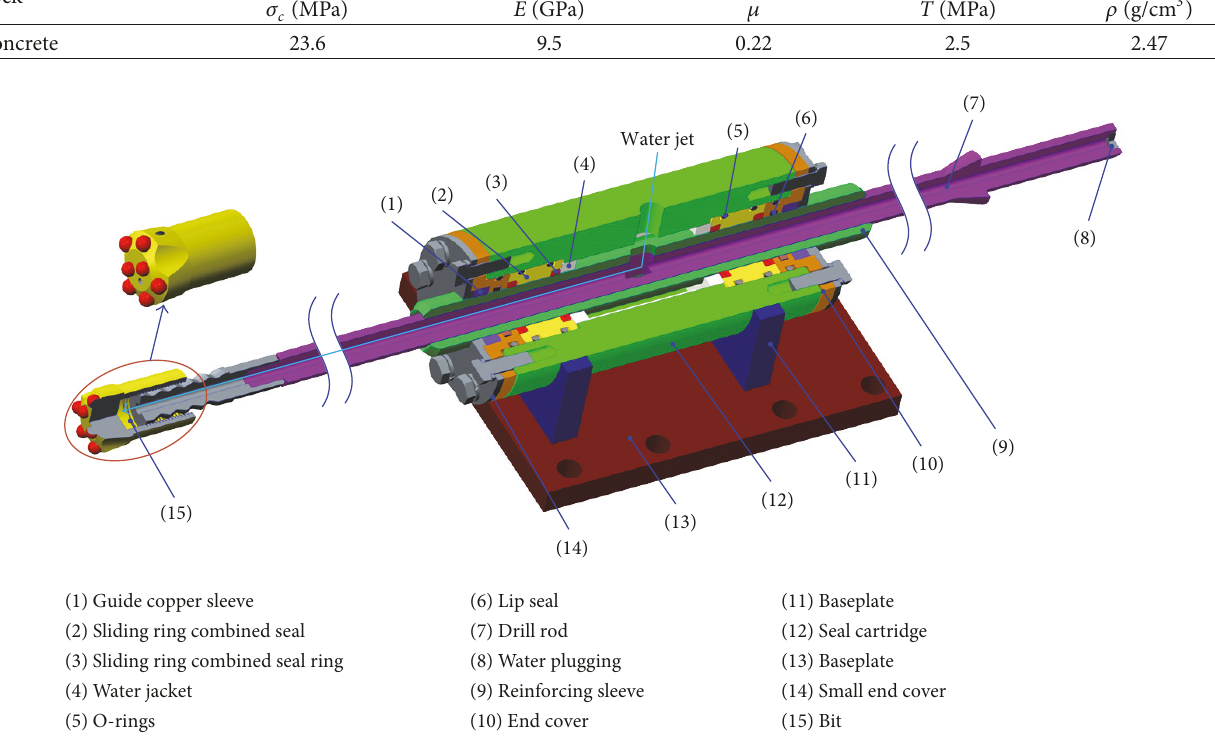
Figure 4: Rotary sealing device with high pressure.